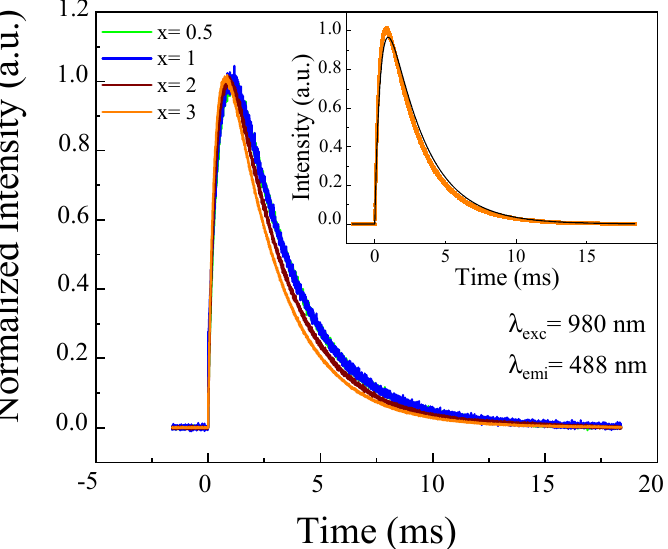
Figure 8. Temporal evolution of Tb 3+ emissions at 488 nm obtained under excitation at 980 nm in 2.5Tb 3+ -xYb 3+ co-doped phosphate glasses. The inset shows the fit of the decay curve for 2.5Tb 3+ - 3Yb 3+ co-doped phosphate glass to Equation (4).